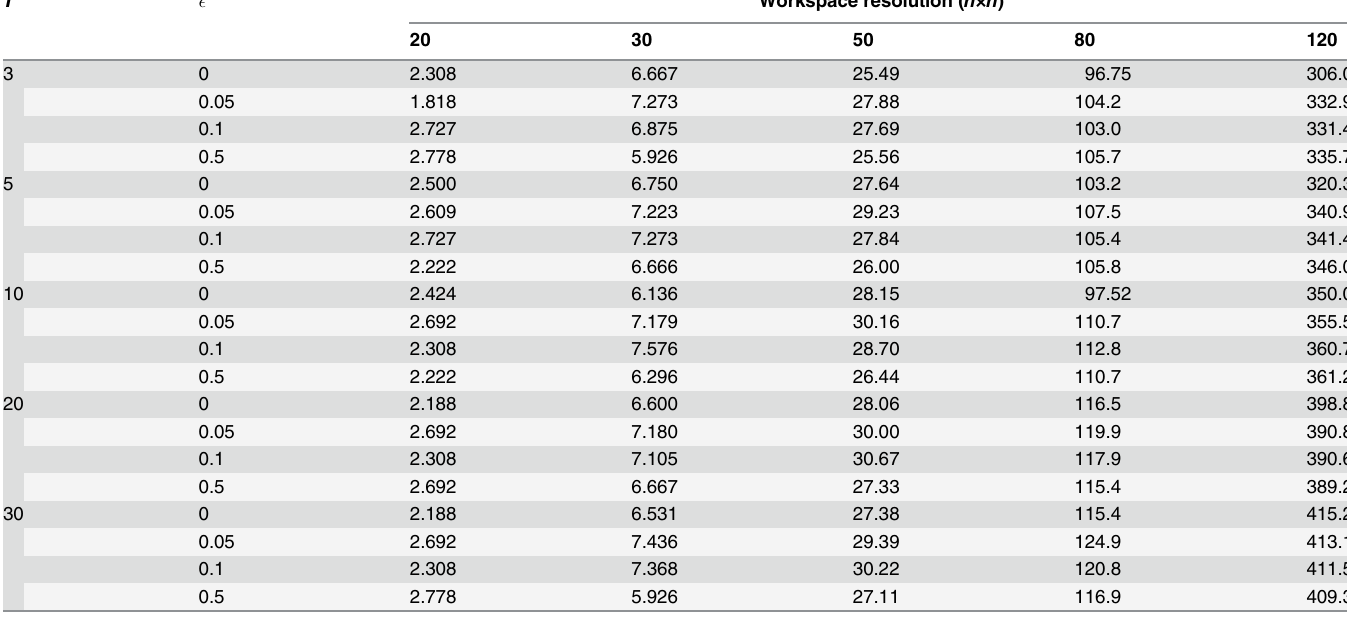
Table 4. Average processing time τ .